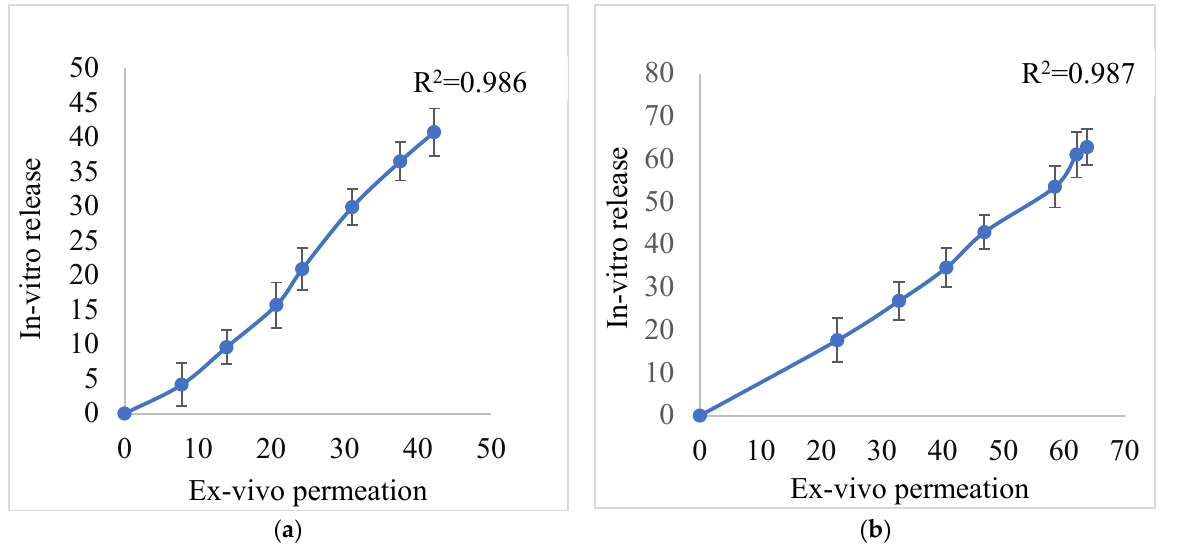
Figure 9. Correlation between in vitro release and ex vivo permeation studies for ( a ) TEF-loaded conventional gel and ( b ) TEF-loaded ethosomal gel. The R 2 value in plots revealed a close linear correlation between in vitro release and ex vivo permeation data in conventional gel a well as in ethosomal gel.